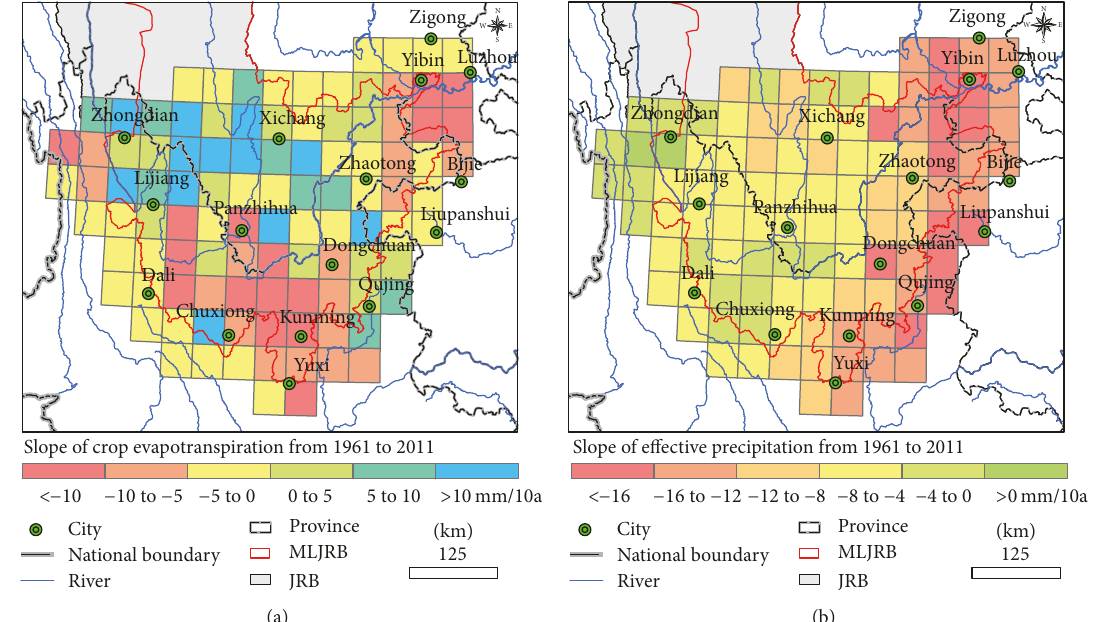
Figure 9: Distribution of slope for the period 1961 to 2011 across the MLJRB: (a) areal crop evapotranspiration; (b) areal effective